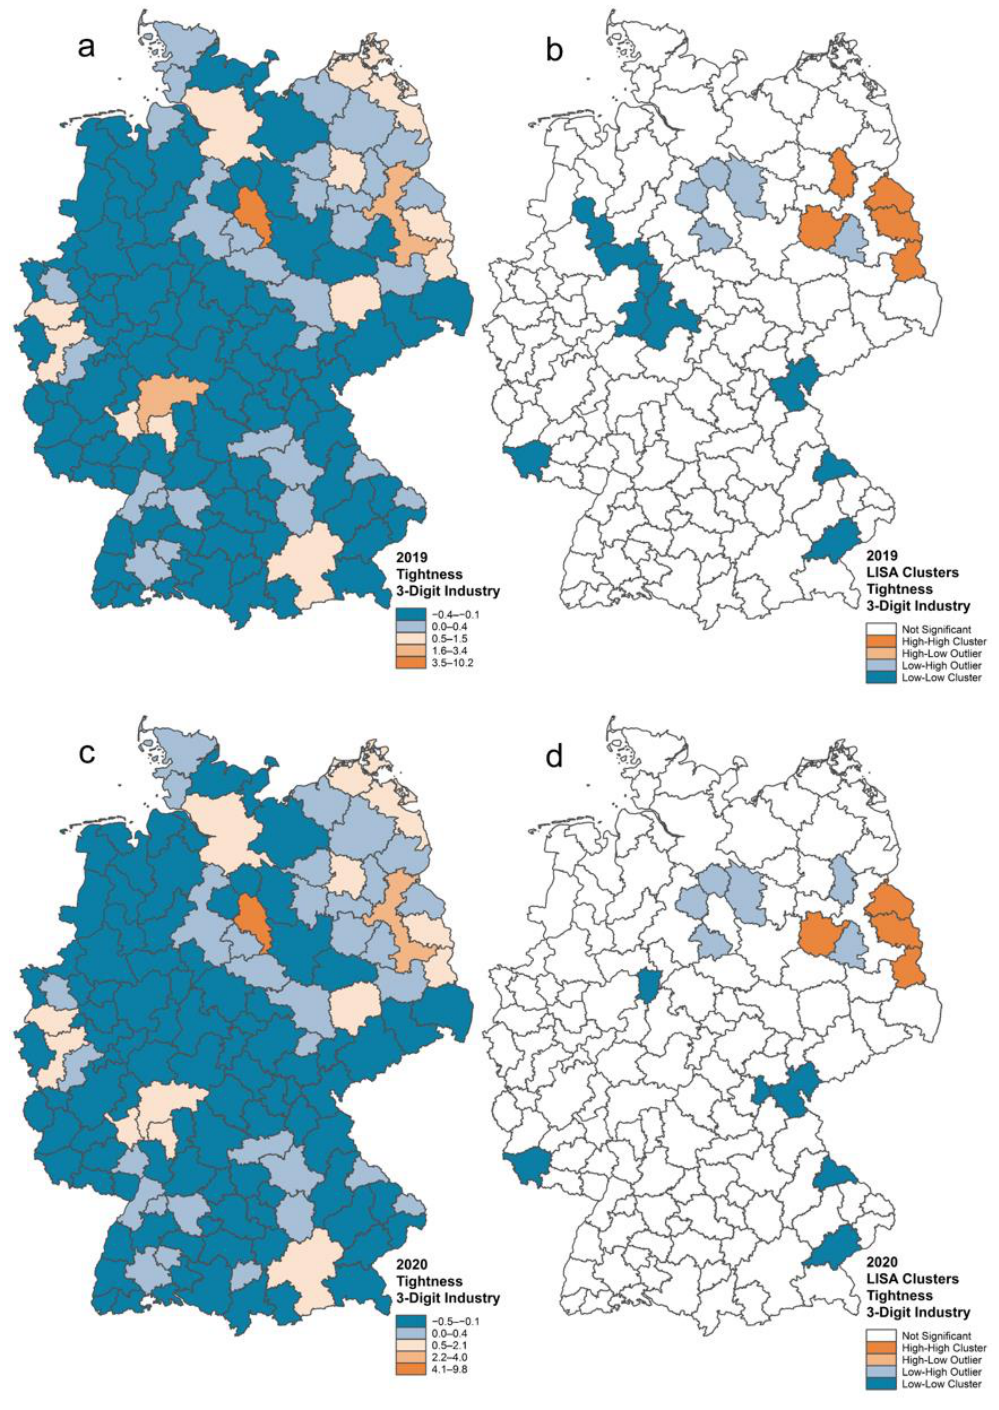
Figure 4. Current spatial distribution and autocorrelation of LMR tightness values, 2019 and 2020. Tightness ( a , c ) and Anselin’s local Moran’s I (LISA) ( b , d ) were calculated at the 3-digit industry code level. Clusters shown in ( b ) are significant at a confidence level of 0.05 using k-nearest neighbors = 4. Between 2007 and 2019 the cluster of high-high tightness areas in Eastern Germany grew in size, while the clusters of low-low tightness in central Germany also grew. Thus, the most recent employment data indicate a growing spatial segregation within Germany in terms of economic tightness.